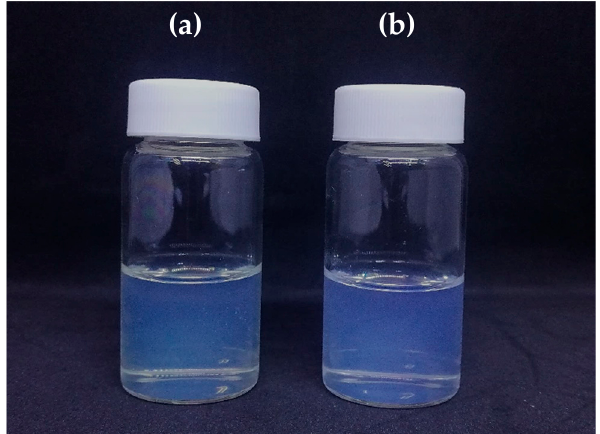
Figure 1. Appearance of ( a ) self nano-emulsifying drug delivery system (SNEDDS) and ( b ) citral-loaded Figure 1. The appearance of ( a ) self nano-emulsifying drug delivery system (SNEDDS) and (b ) self nano-emulsifying drug delivery system (CIT-SNEDDS). CIT-SNEDDS is transparent, clear, rapid citral-loaded self nano-emulsifying drug delivery system (CIT-SNEDDS). CIT-SNEDDS is forming emulsion with a slight opalescence but a bit yellowish in comparison to SNEDDS due to the transparent, clear, rapid forming emulsion with a slight opalescence but a bit yellowish in nature of the Citral oil (pale yellowish comparison to SNEDDS due to the nature of the Citral oil (pale yellowish oil).